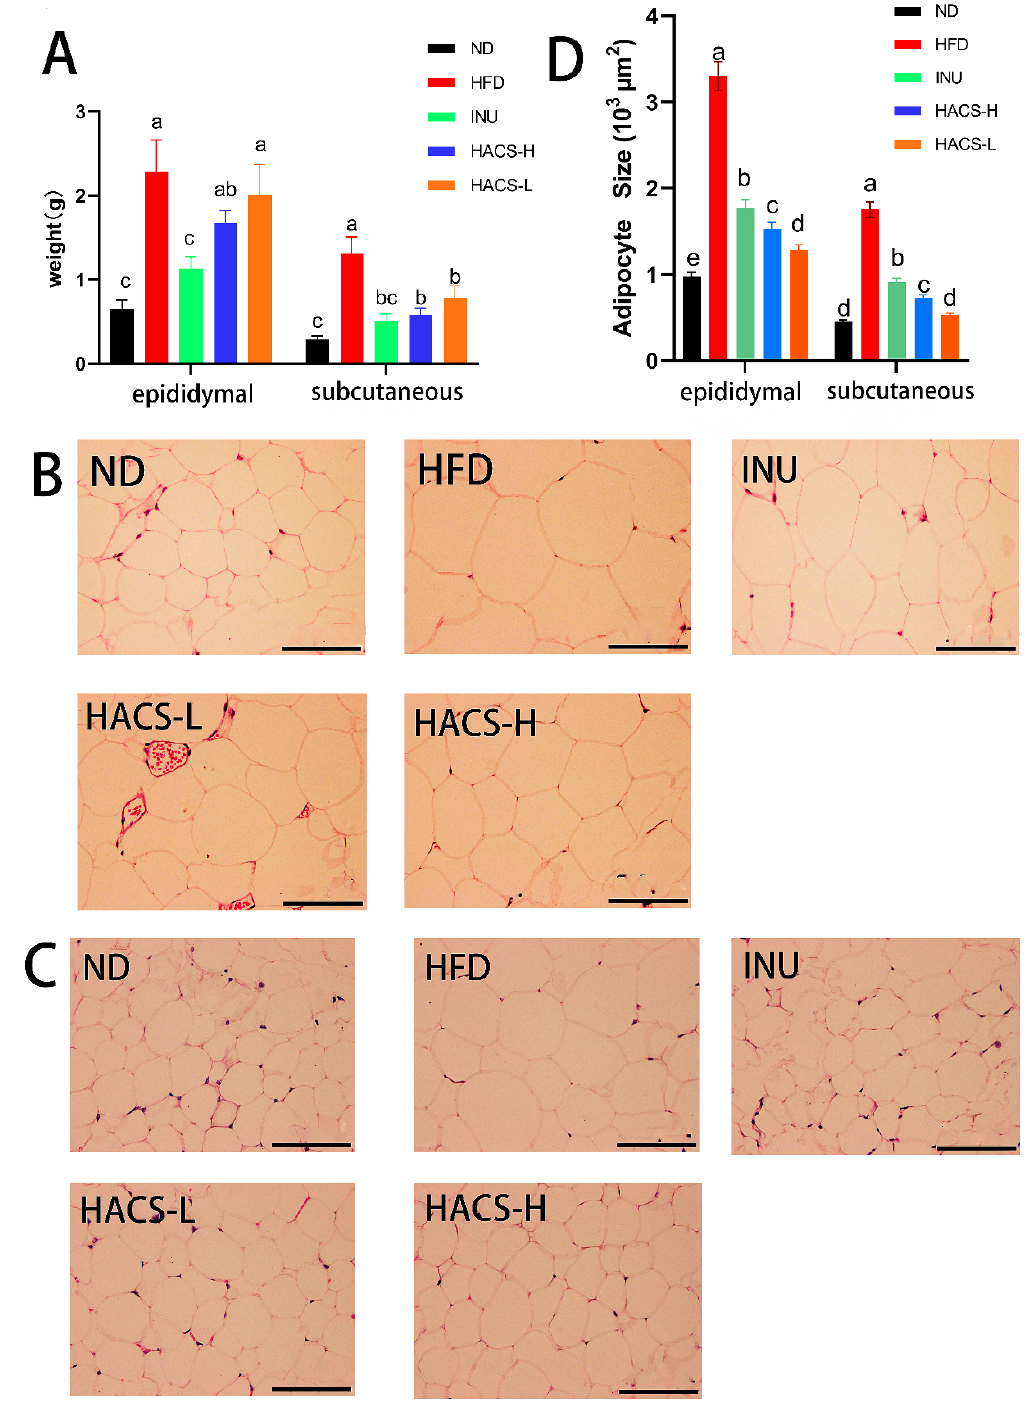
Figure 2. Effects of HACS treatment on adipose tissue. ( A ) the weight of epididymal and subcutaneous adipose tissues; ( B ) the morphology of epididymal adipocytes; ( C ) the morphology of subcutaneous adipocytes; and ( D ) the average adipocyte size. ND, normal diet; HFD, high fat diet; HACS-L, high fat diet + 0.25 g/kg HACS; HACS-H, high fat diet + 0.5 g/kg HACS; INU, high fat diet + 0.5 g/kg inulin. Data were expressed as the mean ± SD ( n = 5 per group). Different lowercase letters represent significant differences ( p < 0.05), and the same lowercase letters represent no significant differences ( p ≥ 0.05). The scale bars represent 100 μ m.